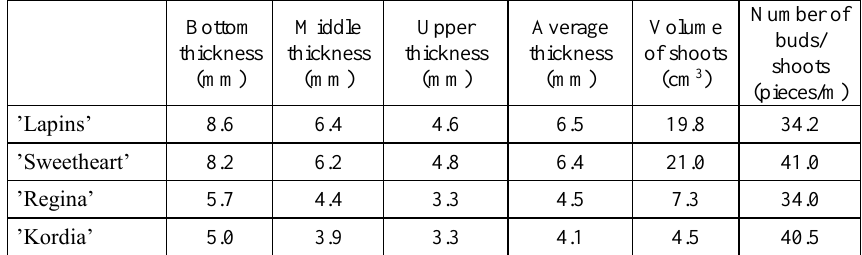
Table 7. Parameters of the shoots (Debrecen – Pallag,